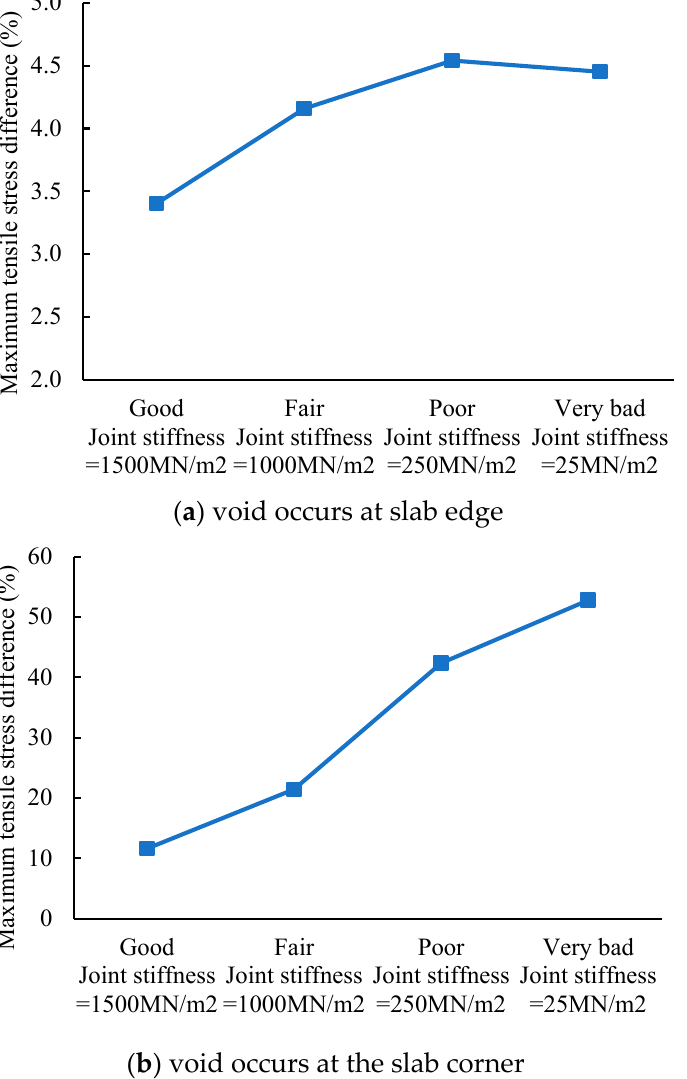
Figure 17. Maximum tensile stress difference between the “without separator layer-void” condition and “with separator layer-no void” condition.